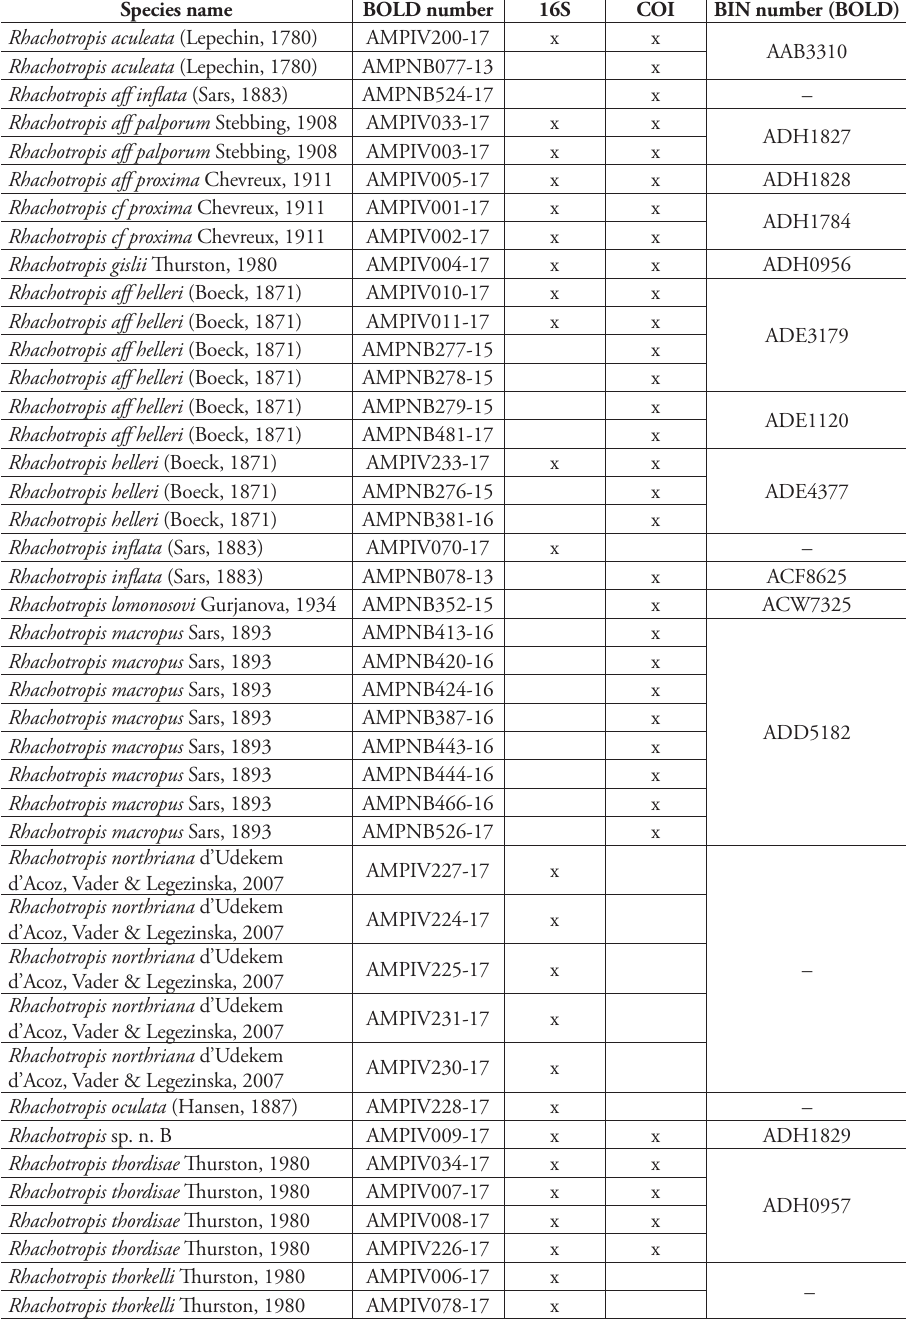
Table 1. Overview of Rhachotropis sequences produced for this work, with BOLD accession numbers and BIN numbers (BOLD). The dataset can be accessed using